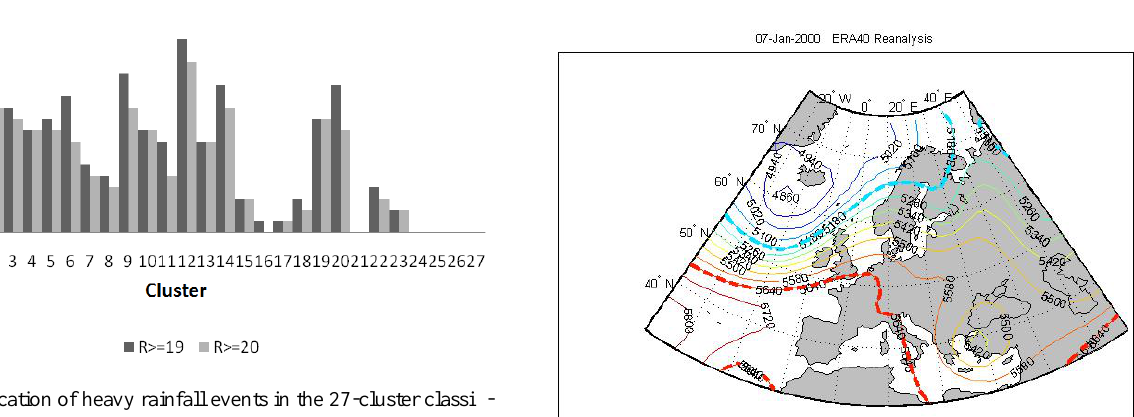
Fig. 7. Allocation of heavy rainfall events in the 36-cluster classification.